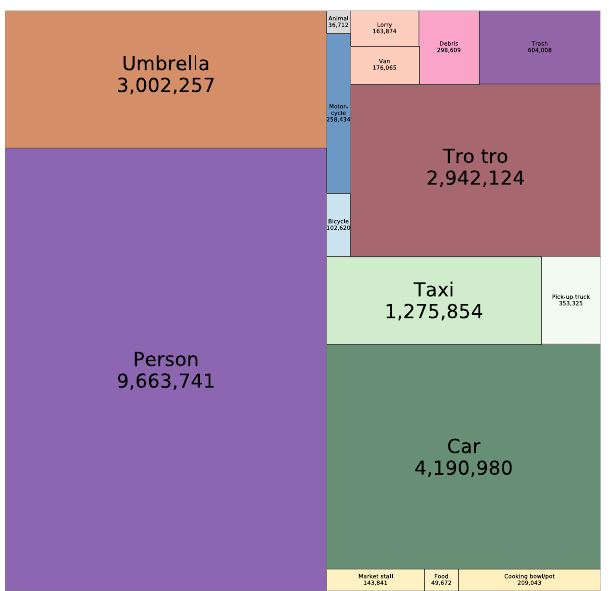
Figure 3. Count of different objects in the Accra image set. The size of each rectangle shows the total numbers of the corresponding object in the entire set of 2.10 million images. Four of the identified objects are not seen in the figure because their numbers were zero (loudspeakers and cookstoves) or very small (98 market vendors and 14